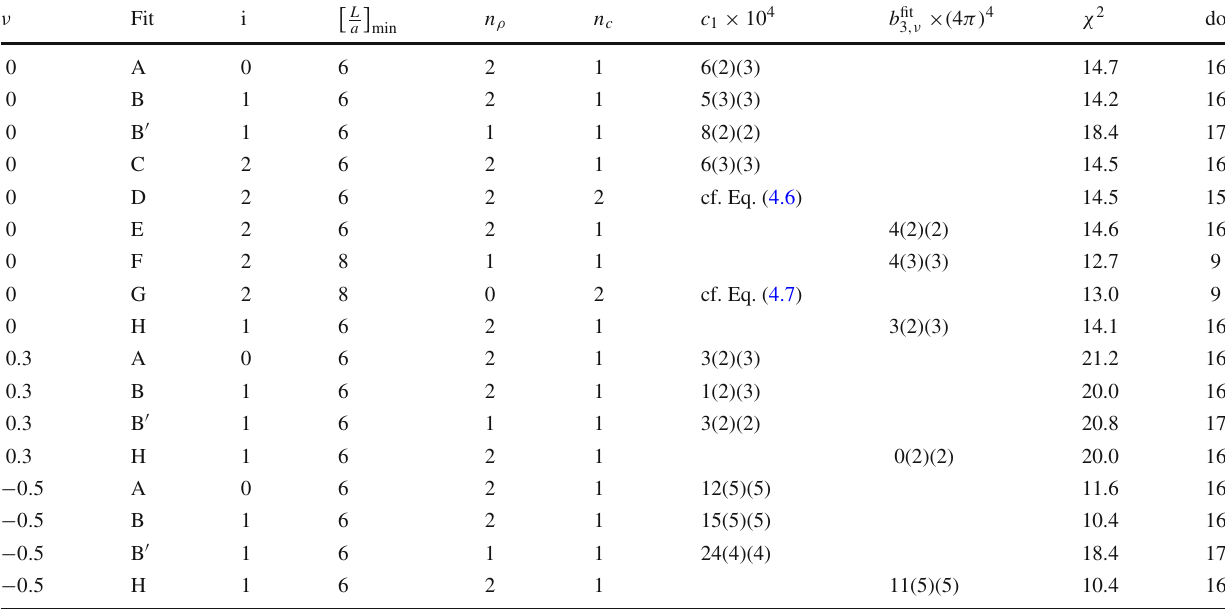
Table 5 Overview of the continuum fit functions and results. The nam- ing convention is the same as in Ref. [1]. The two errors in the fit param- eters are the statistical and the total error respectively, where the total